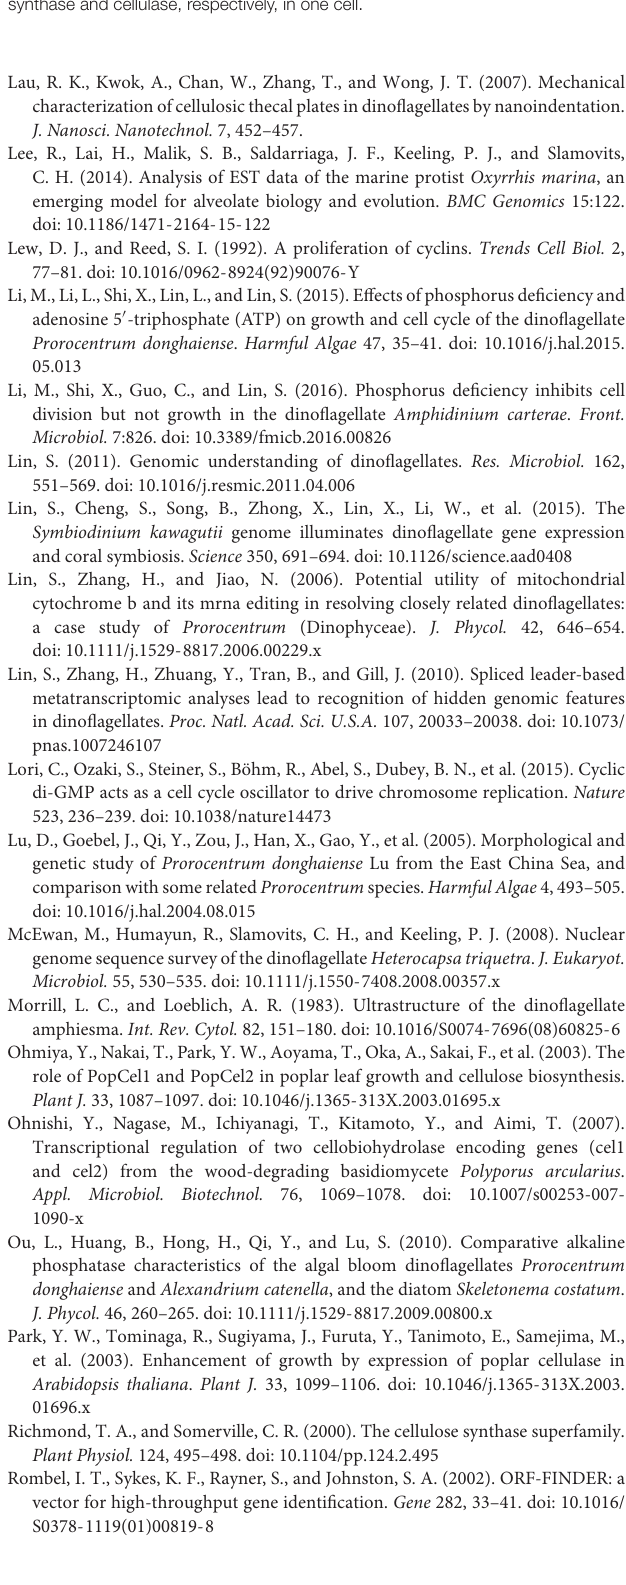
amounts of P. donghaiense genomic DNA (DNA equivalent to 2, 10, and 50 ng), each in triplicate, were used as unknown samples, which gave estimate